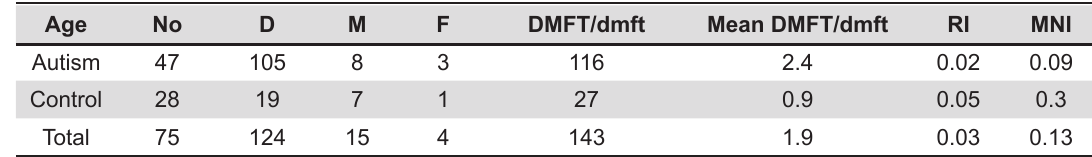
Table 2- Mean decayed, missing and filled teeth (DMFT/dmft), Restorative Index (RI) and Met Need Index (MNI) for the two groups